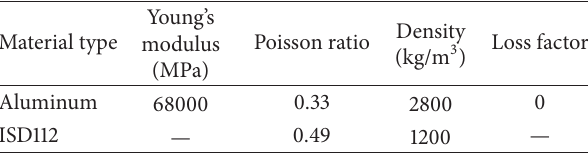
Table 1: Material properties.